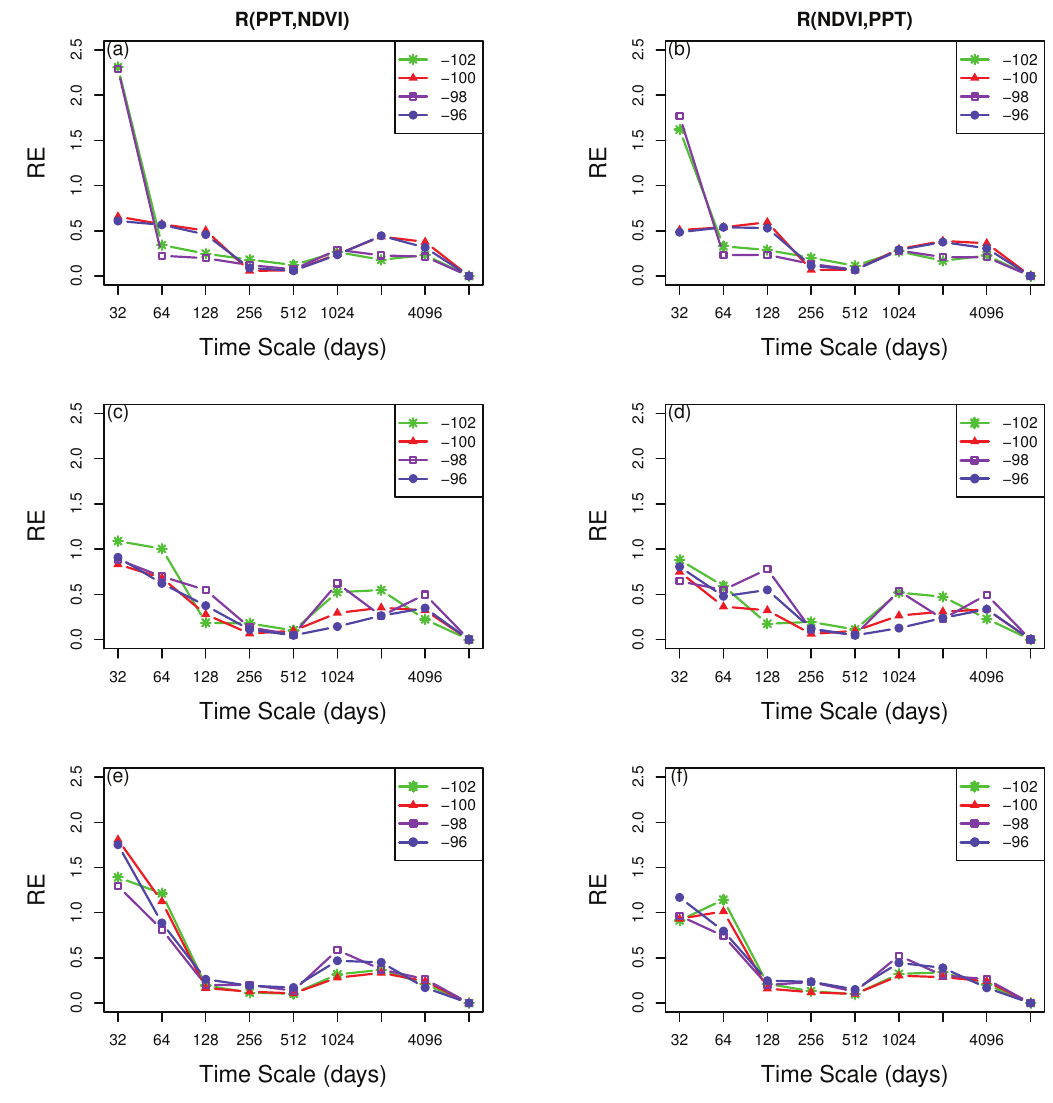
Figure 9. Multi-resolution relative entropy between NDVI and PPT as a function of temporal scale in ( a , b ) entire KRB; ( c , d ) irrigated corn; ( e , f ) C4 grassland for selected longitudes: 102 W (green line with star), 100 W (red line with triangle), 98 W (purple line with rectangle) and 96 W (blue line with